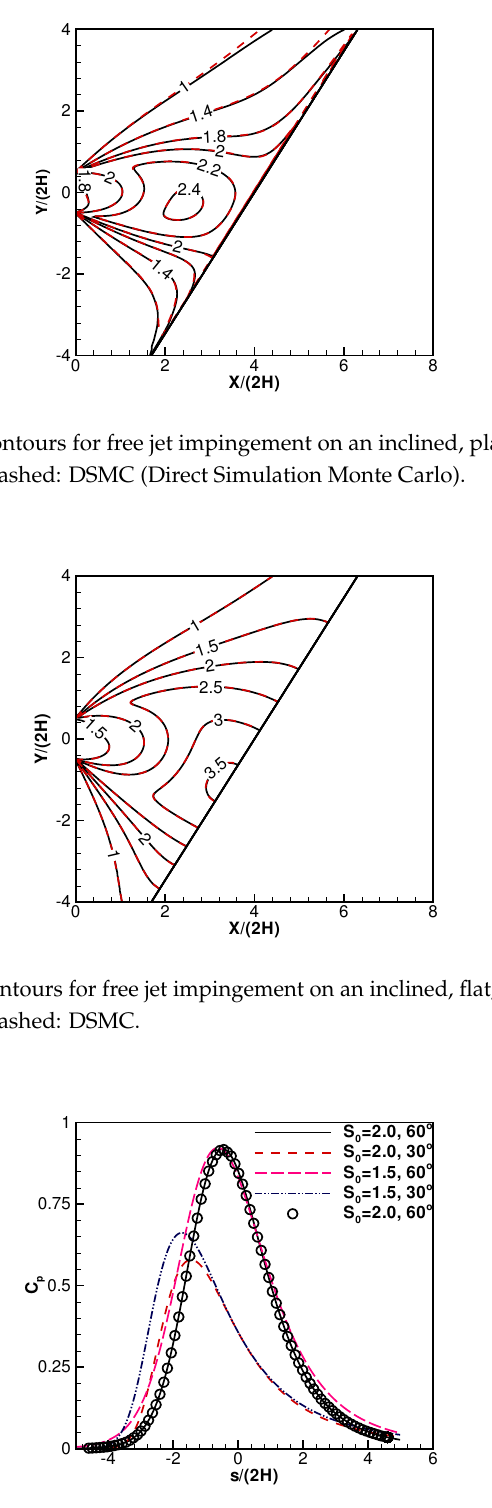
Figure 7. Diffuse planar plate, surface C p , d ( s ) , T w / T 0 = 1.5. Lines: analytical; symbols: